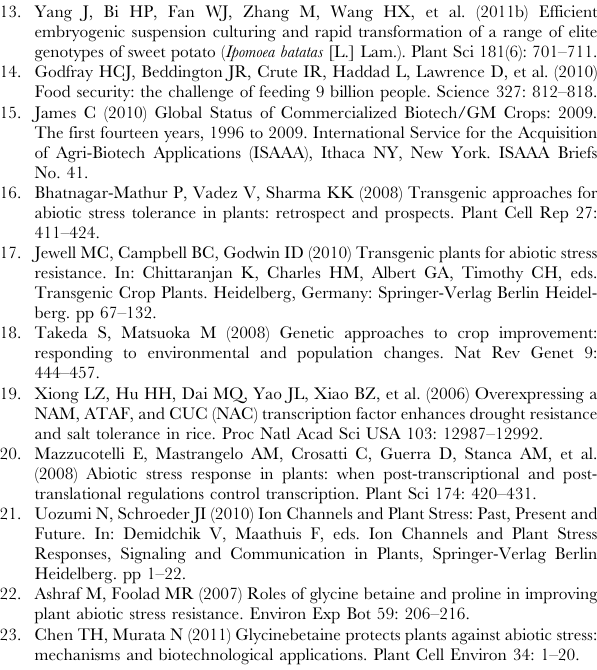
Figure S1 Schematic representation of the T-DNA region of pCSoBADH harboring the SoBADH- , HPT- and uidA -expressing cassettes. (TIF) Figure S2 Analysis of GUS activity in the leaves of transgenic sweet potato plants (OE1–OE9) showing the transgenic nature by dark-blue and non-stained wild- type plants (WT). (TIF) Figure S3 Molecular characterization of the SoBADH transgenic sweet potato plants. (TIF) Figure S4 Relative expression of the BADH , CMO , PRK and psbA genes in the leaves of wild-type (WT) and SoBADH transgenic (OE) plants under the NaCl, MV and cold treatments. (TIF) Table S1 Primers used for gene amplification by real time